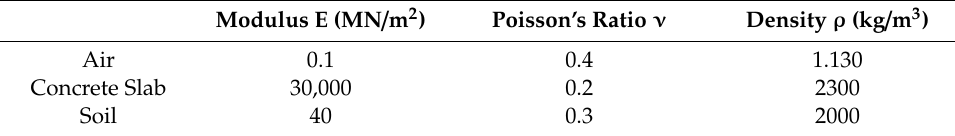
Table 1. Input parameters for finite element modeling of railway track section.